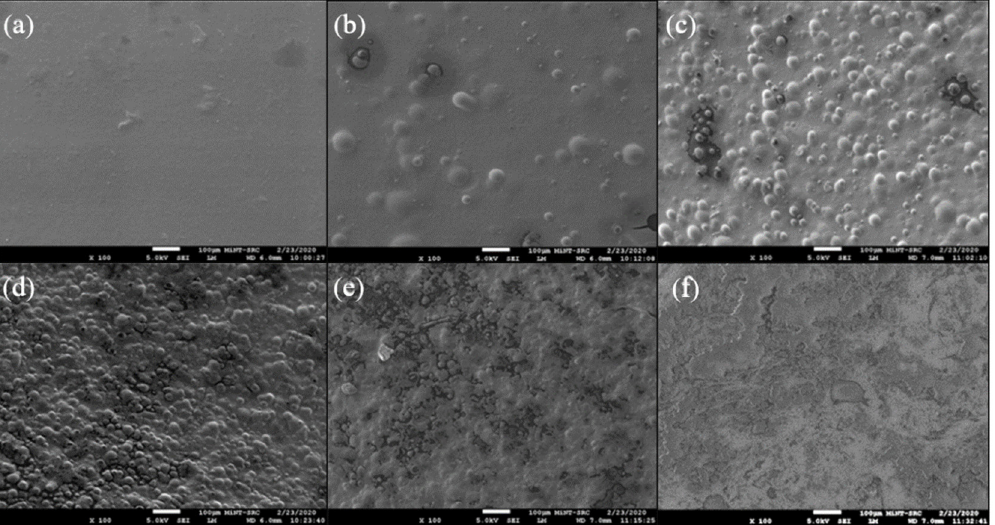
Figure 10. The surface morphologies of ( a ) AG10:50, ( b ) AGLC01, ( c ) AGLC05, ( d ) AGLC10, ( e ) AGLC20, and ( f ) AGLC40.